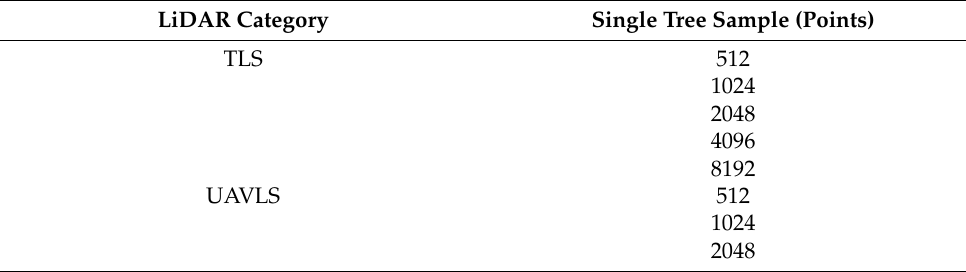
Table 4. Single tree point cloud data